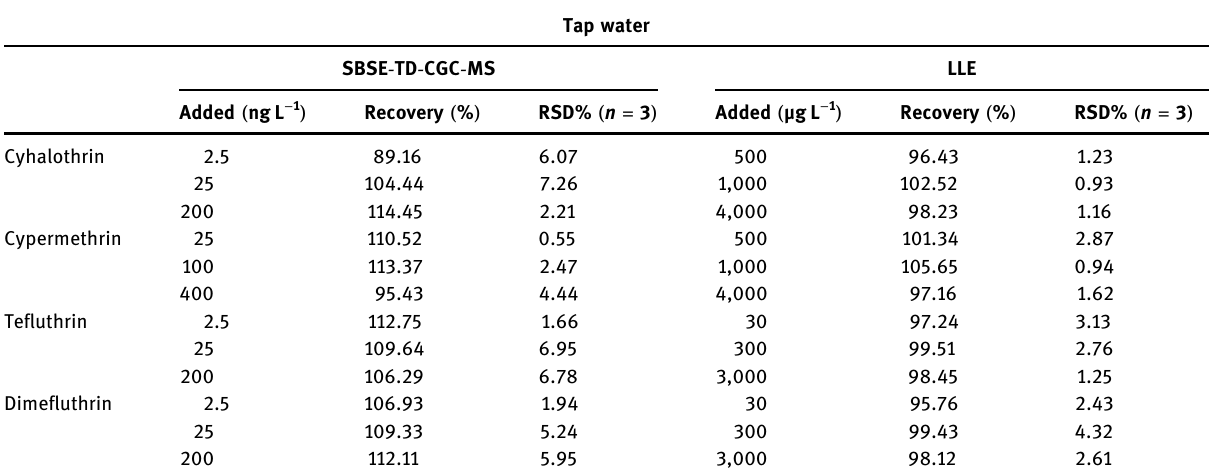
Table 3: Results for the analysis of cyhalothrin, cypermethrin, te fl uthrin, and dime fl uthrin in spiked real samples with SBSE - TD - CGC - MS and LLE.